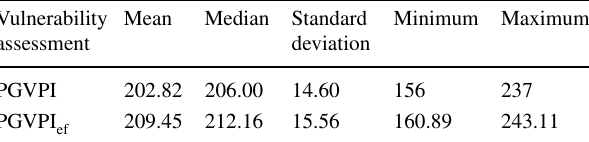
Table 5 List of selected statistical values of groundwater vulnerabil- ity to pollution assessment results for theoretical weights and weights subjected to sensitivity analysis in the variant of sensitivity of one